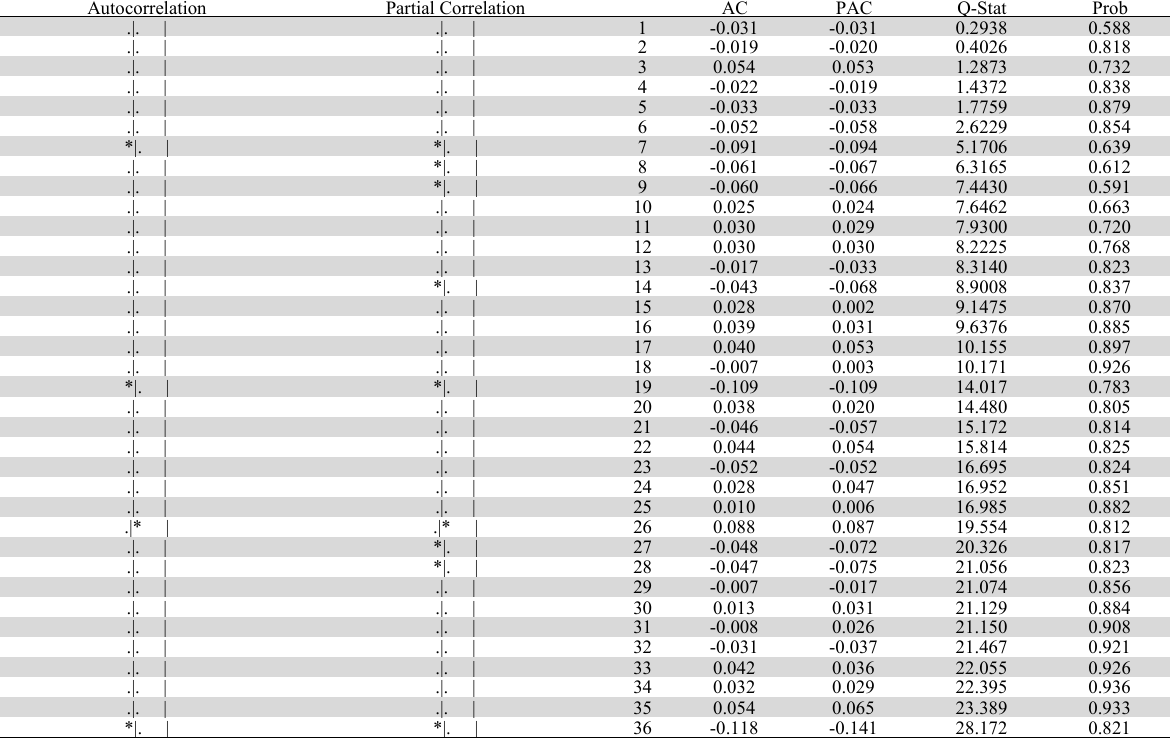
Autocorrelation Partial Correlation